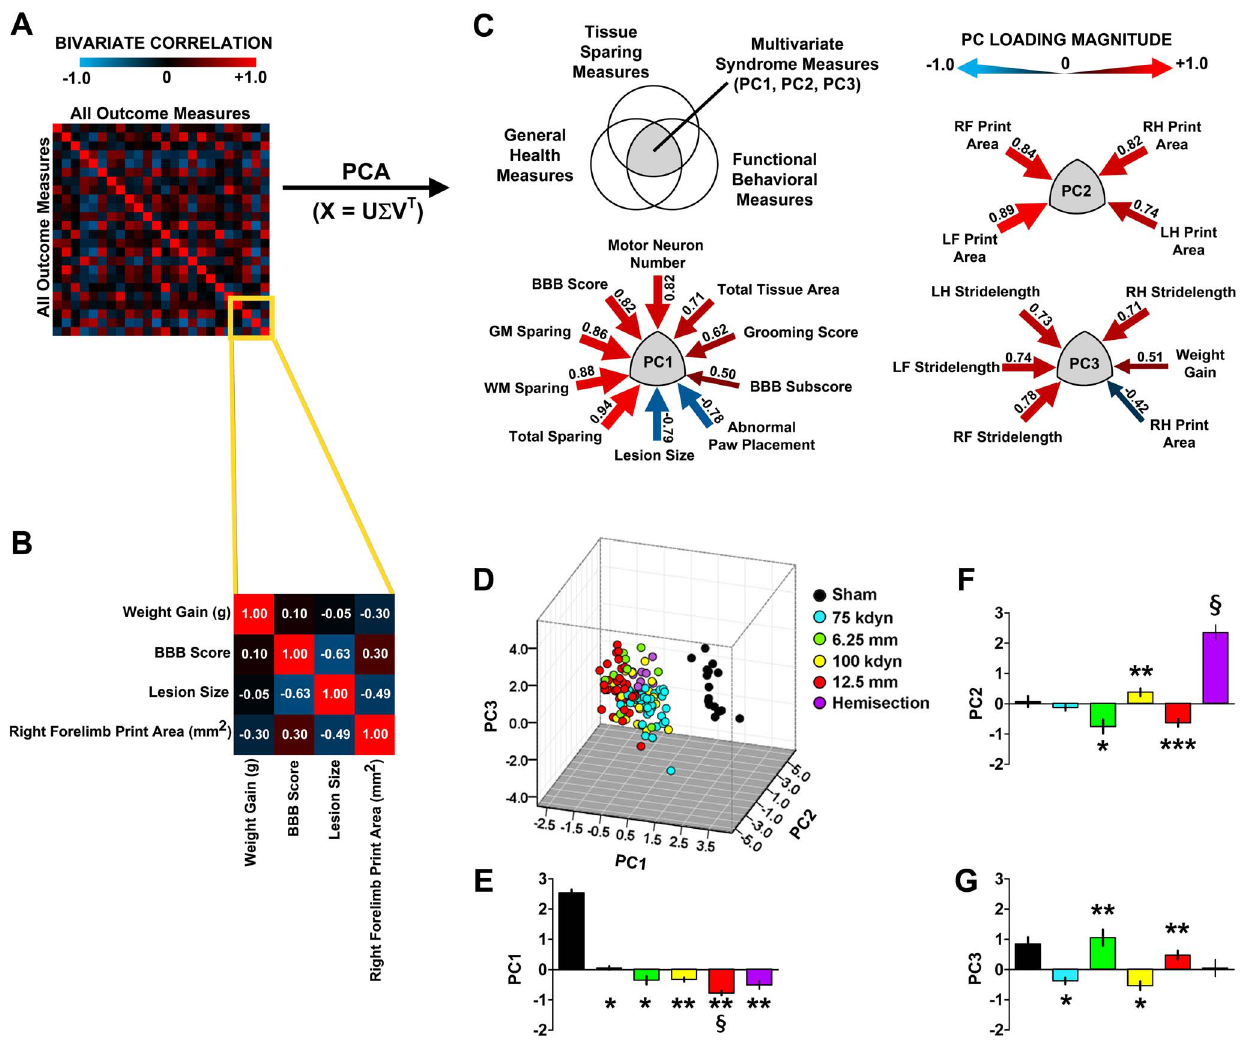
Figure 4. Multivariate analysis of the SCI syndrome using data from two research sites. A, Heat map of the bivariate correlation matrix, indicating all cross-correlations between behavioral and histological outcomes sorted in a randomized fashion. Blue indicates negative relationships and red indicates positive relationships. Heat reflects magnitude of Pearson correlation (r). B, Zoomed view of a small portion of the correlation matrix showing the interrelationships between a subset of outcomes. C, Principal components analysis (PCA) by eigenvalue decomposition was used to reduce the correlation matrix to synthetic multivariate variables known as principal components (PCs). PCs reflect clustered variance shared by numerous outcome measures. PC identities are indicated by significant PC loadings (arrows, loadings | . .40|). Each loading is equivalent to a Pearson correlation between individual outcomes and the PC. Loading magnitude is indicated by arrow width and heat (blue reflects negative and red reflects positive relationships). Exact loading values are shown next to each arrow. See Fig.S1 for non-significant loadings. D, Plot of individual subjects (N=159) in the 3D multivariate syndrome space described by PC1-3. E–G , 2D plots of PC1-3 on their own axes. Significant differences: E, * P , .05 from sham, ** P , .05 from 75 kdyn and sham, 1 P , .05 from all groups except 6.25 mm. F, * P , .05 from sham, ** P , .05 from all groups but sham, *** P , .05 from sham, 75 kdyn, 100 kdyn and hemisection. 1 P , .05 from all other groups. G, * P , .05 from sham, ** P , .05 from 75 and 100 kdyn.